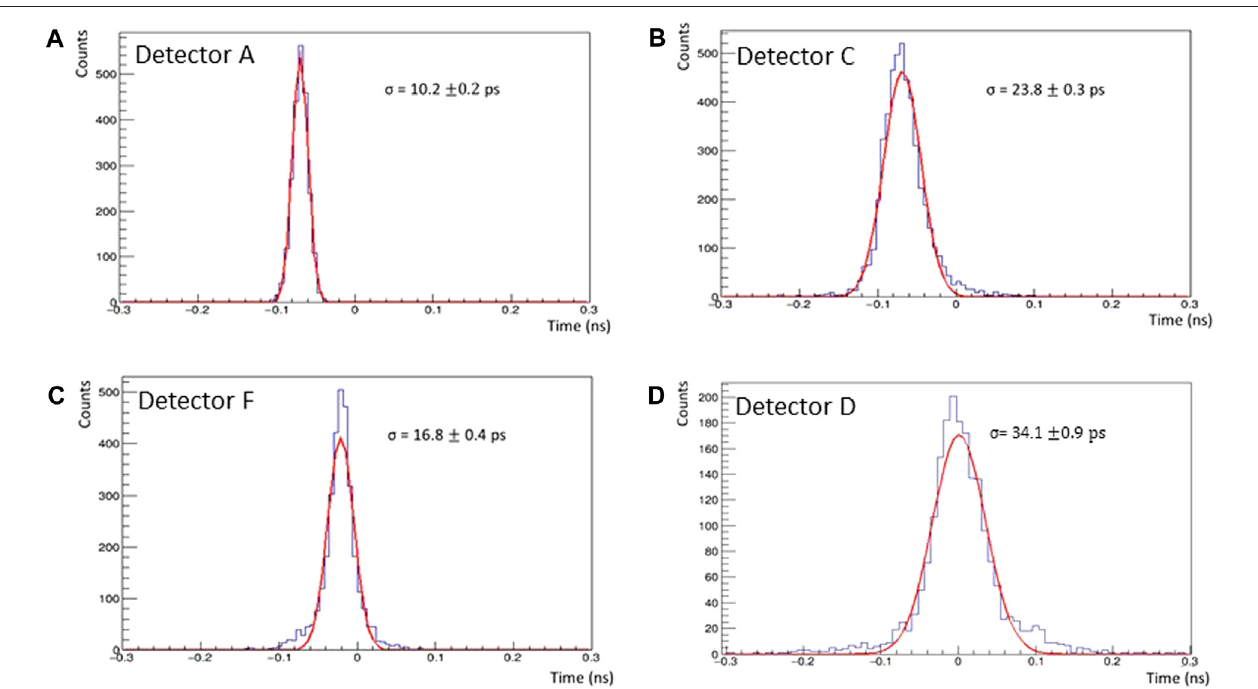
FIGURE 12 | Time resolution (RMS) measured on sCVD diamond detector A (A) , pCVD diamond detectorc C (B) and D (D) and the DOI diamond detector F (C) with FF98 at 90 MeV kinetic energy impinging on the detectors under 0 ⁰ . The time value corresponds to the difference in time from the two signals extracted from each side of a single detector after preampli fi